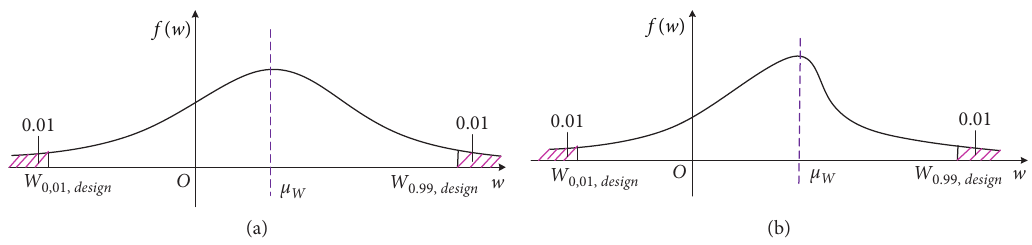
Figure 5: Diagram of the relationship between two design wind load: W Gaussian distribution case.